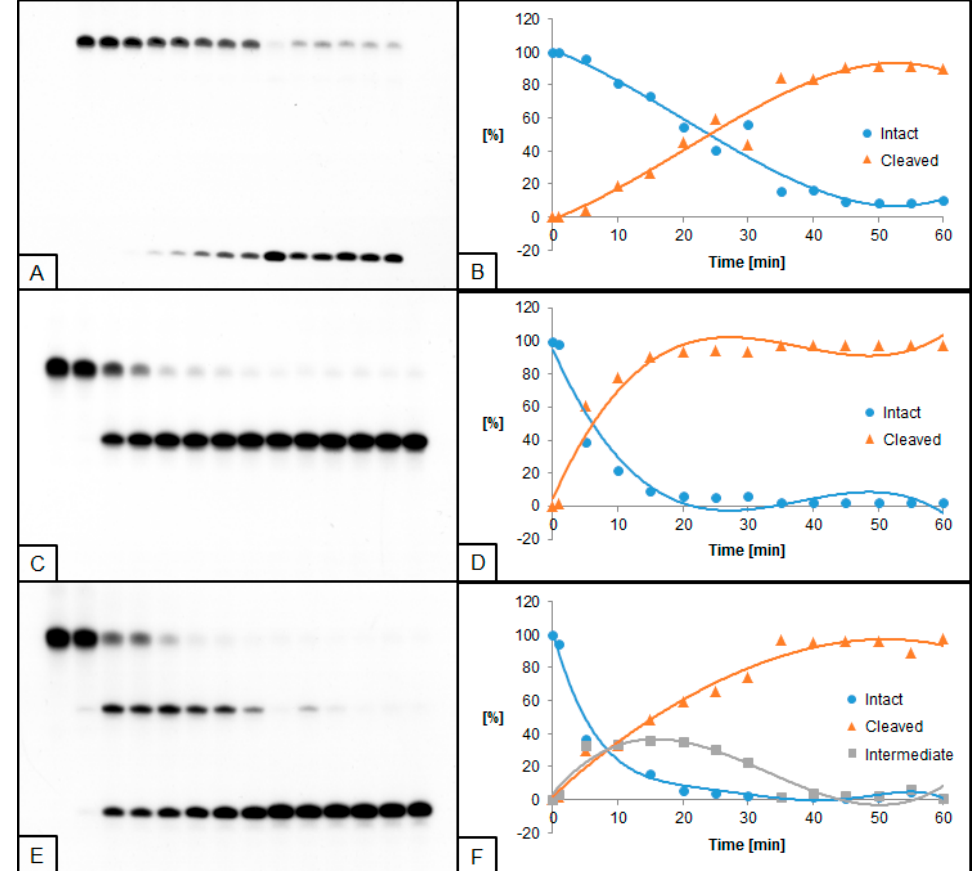
Figure 1. Cleavage of dsDNA containing dU and (5 ′ S ) − 5 ′ ,8-cyclo-2 ′ -deoxyadenosine (ScdA) by 0.02 U UDG and 0.5 U hAPE1. ( A , B ) dU( − 5)ScdA; ( C , D ) dU(+5)ScdA; ( E , F ) dU( − 5)(+5)ScdA. ( A , C , E ) show 14 lanes each, which correspond to reaction times 0, 1, 5, 10, 15, 20, 25, 30, 35, 40, 45, 50, 55, and 60 min starting from the left. ( B , D , F ) show the quantity losses of intact ssDNA (blue), the quantity increases of SSB-DNA (orange), and an intermediate oligo fragment (grey).